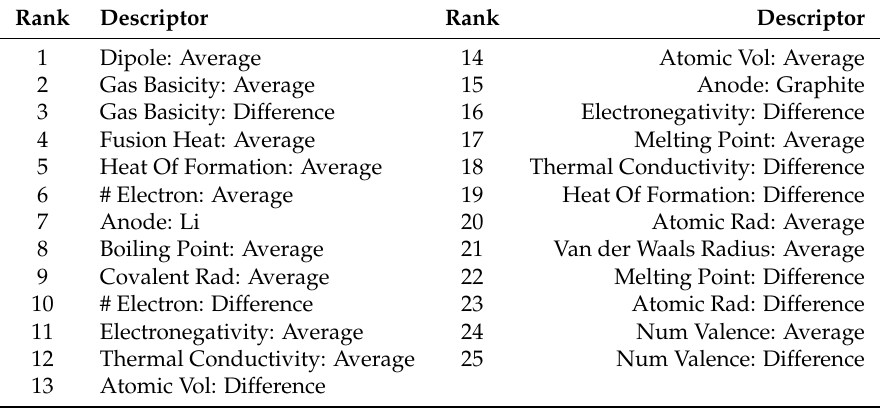
Table A2. The 25 descriptors used for reported model performance and their ranked importance.